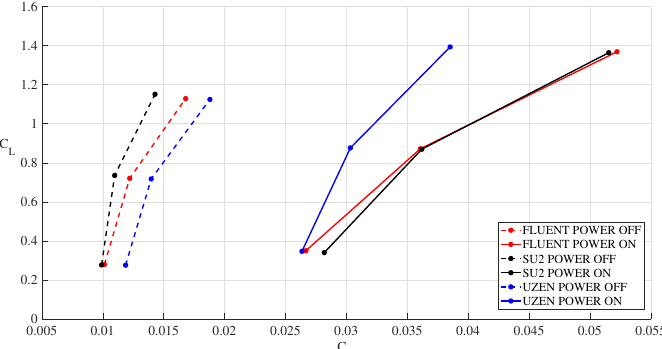
Figure 25. C D − C L curve for power-off and power-on